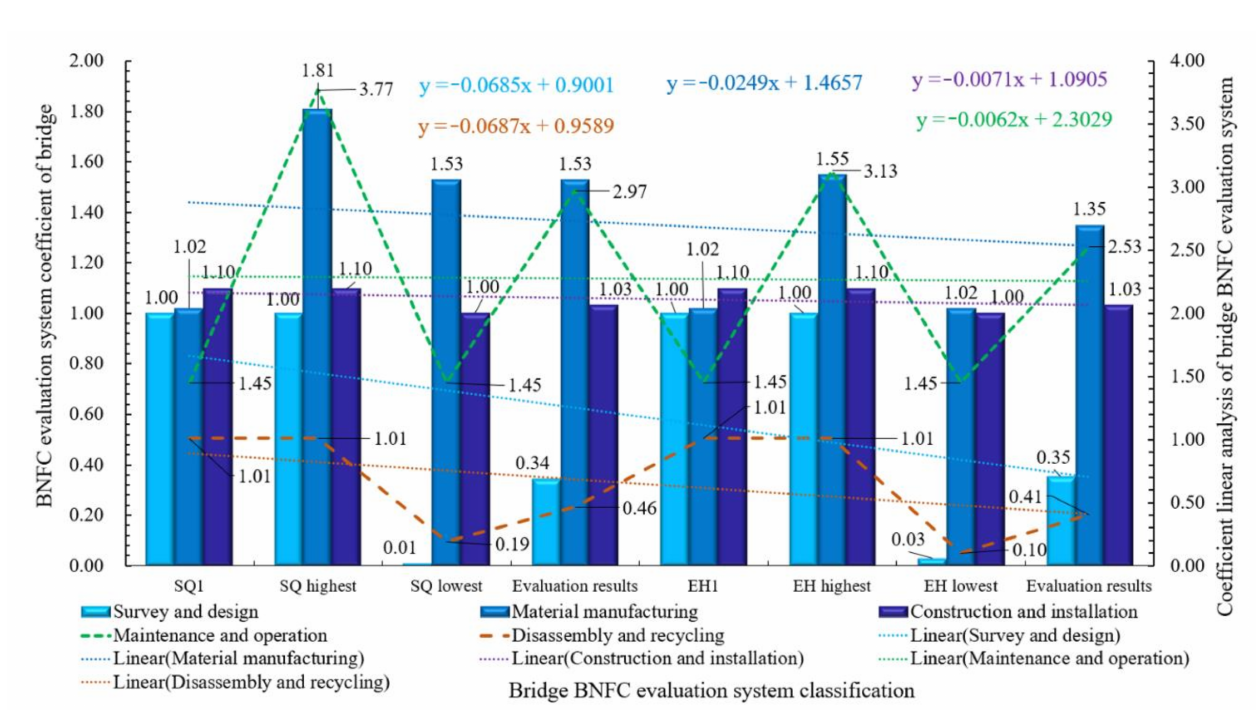
Figure 12. Chart of impact factor deviation analysis for SQ and